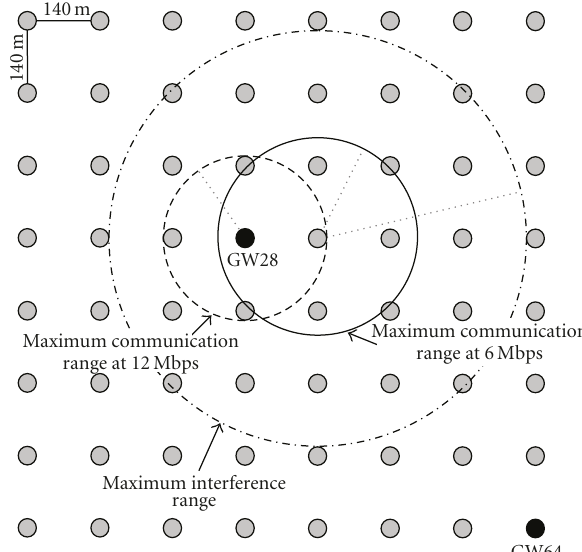
Table 3: Fixed simulation